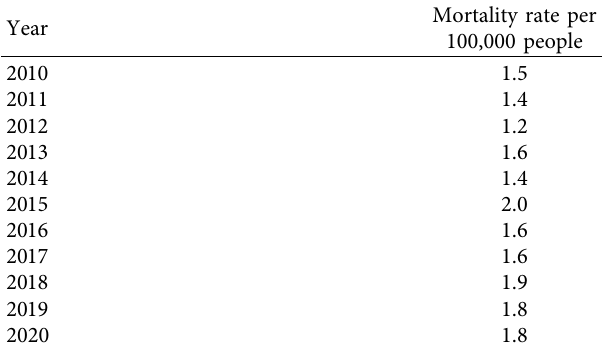
Table 5: STS mortality rate per 100,000